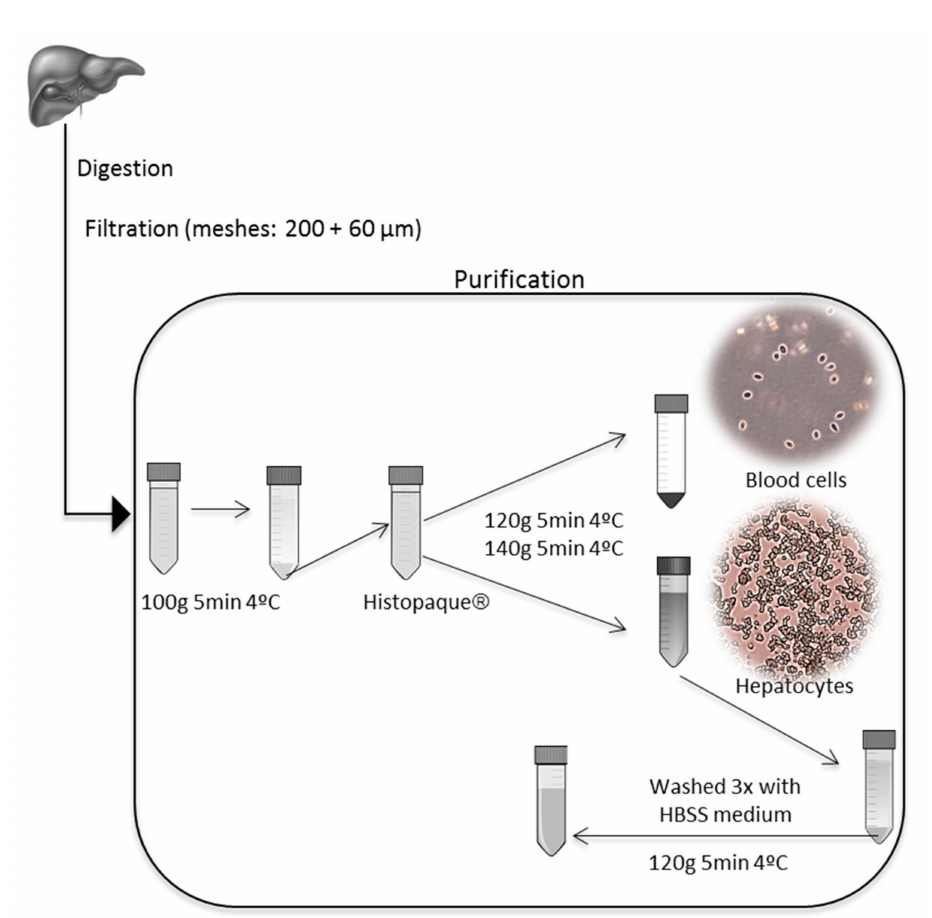
Figure 2. Pancreatin digestion method by Yanhong et al. [24] with modifications to increase culture